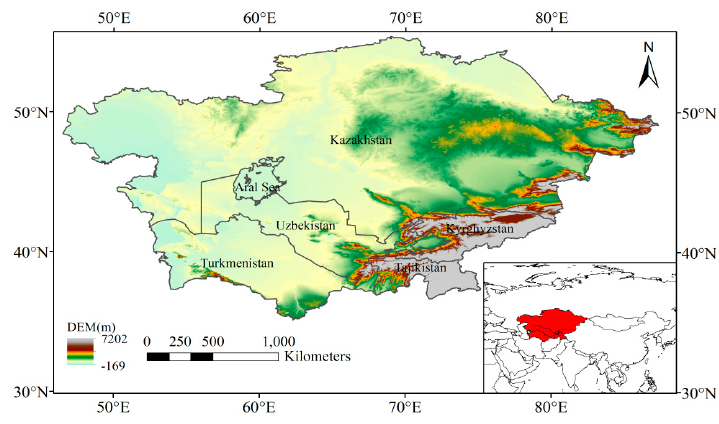
Figure 1. Topography and administrative map of Central Asia.